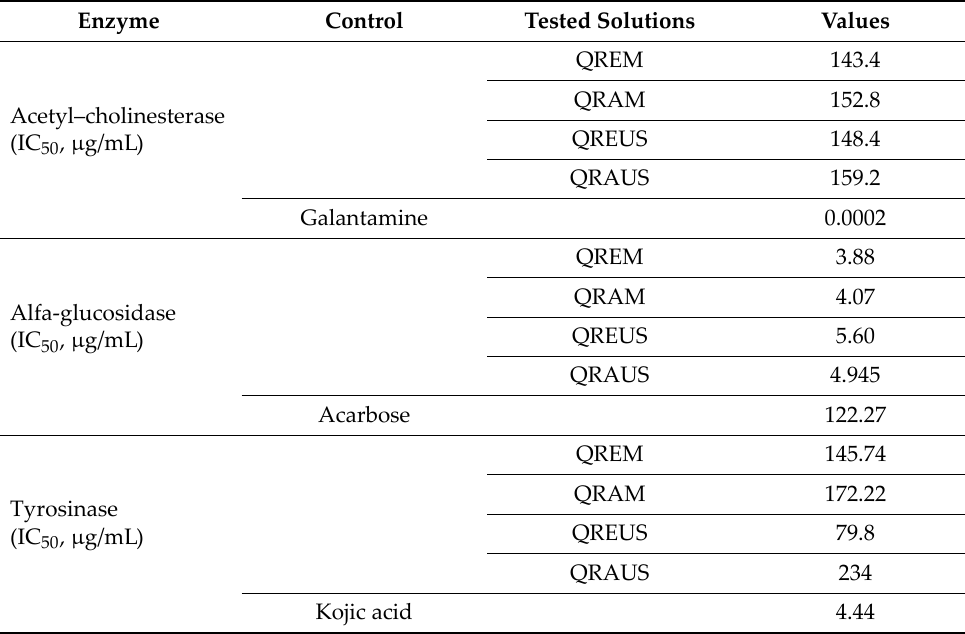
Table 5. The in vitro enzyme inhibitory activity of the oak bark